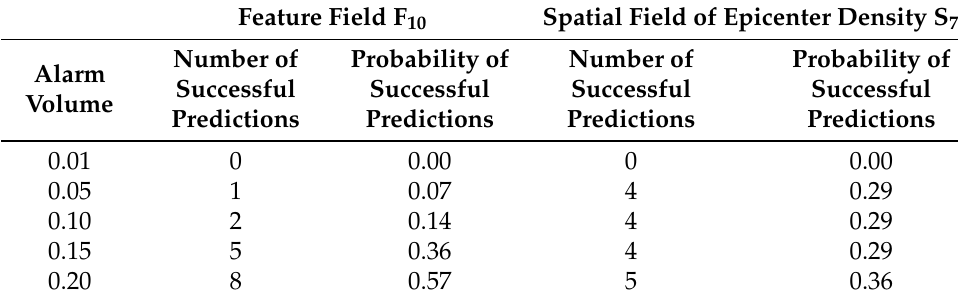
Table 3. Japan. Probabilities of predicting earthquakes with magnitudes m ≥ 6.0.